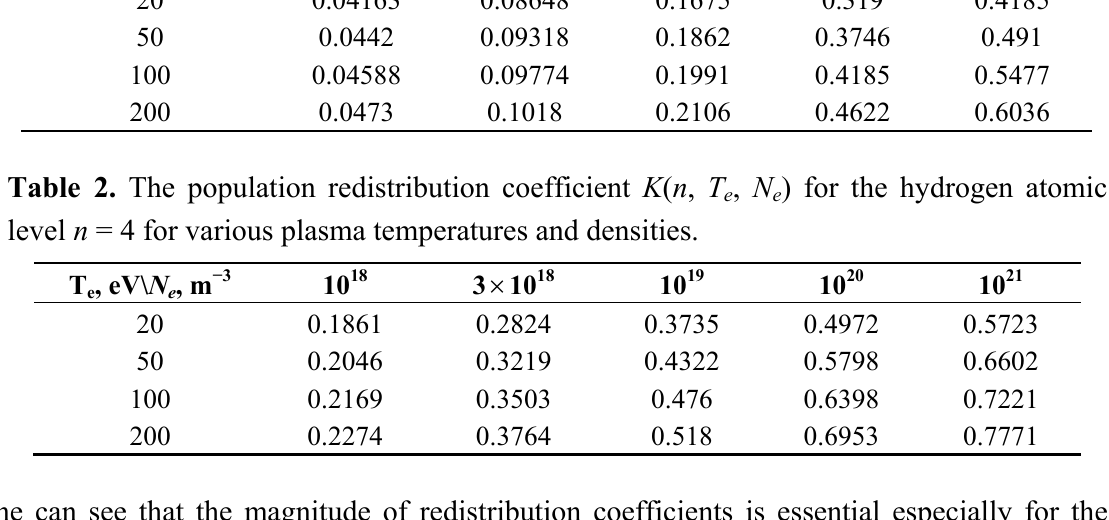
Table 1. The population redistribution coefficient K ( n , T level n = 3 for various plasma temperatures and densities.